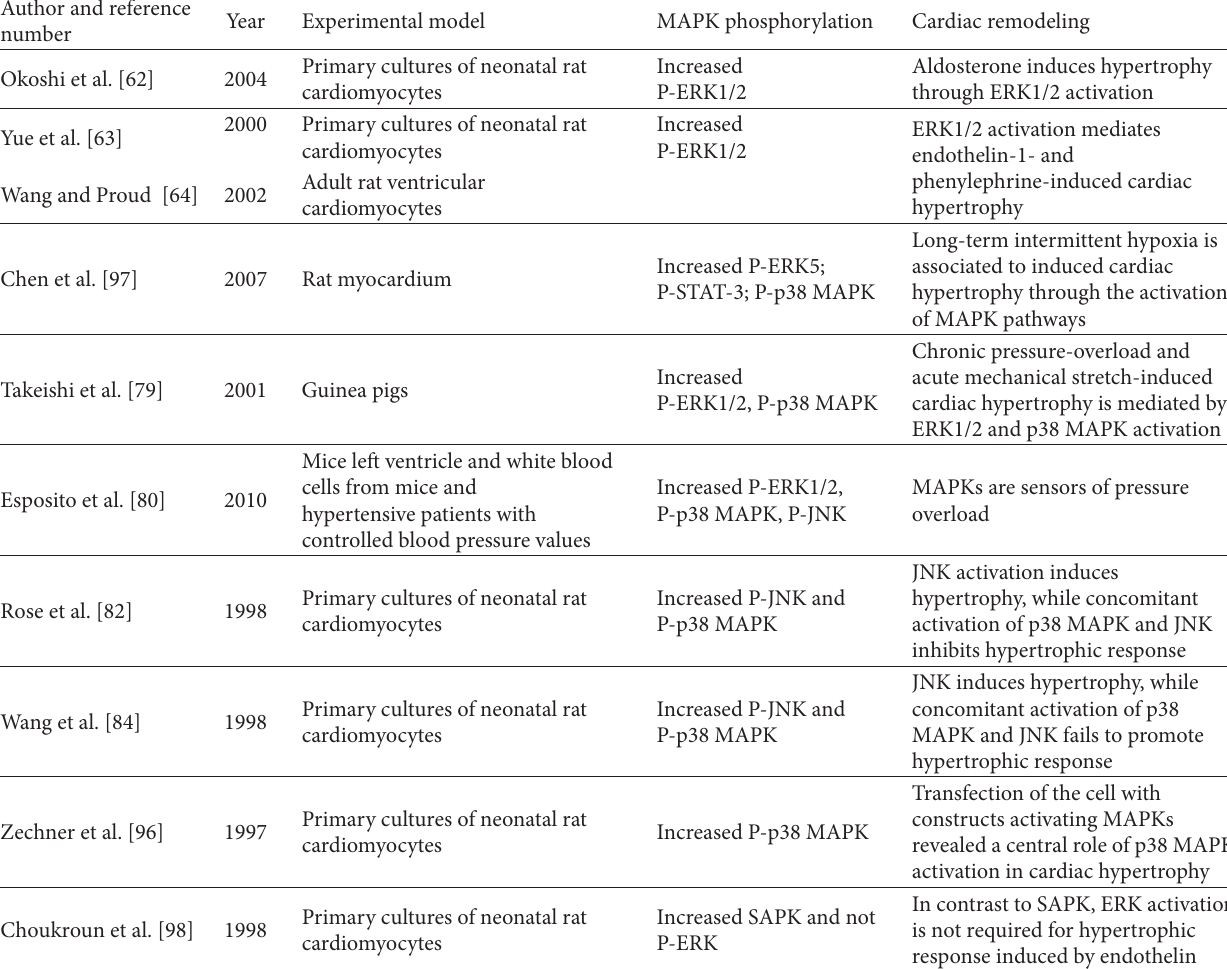
T 2: Role of MAPK activation in metabolic syndrome-associated cardiac